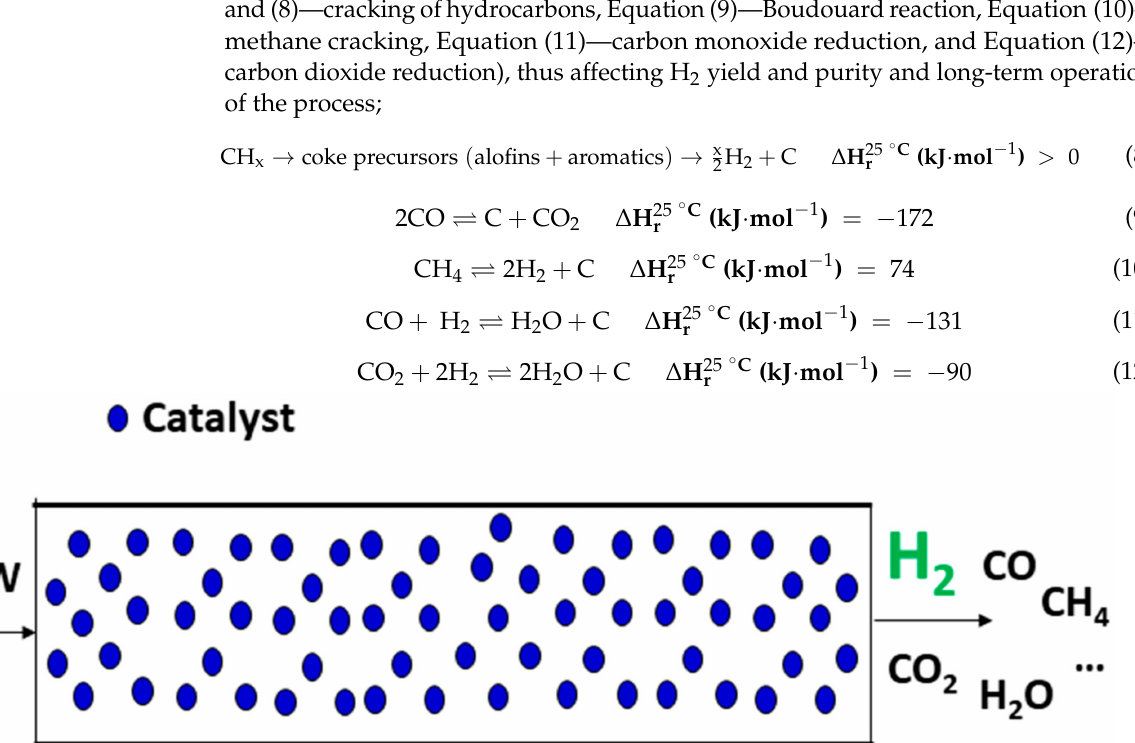
Figure 7. Scheme of the operation of the